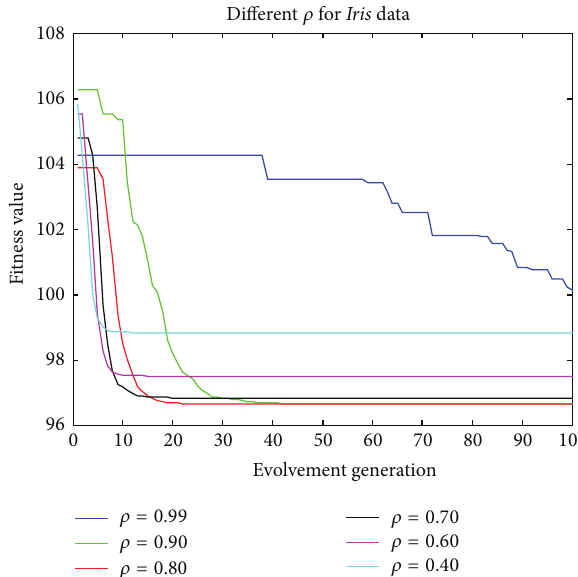
Figure 18: The convergence curve of the Iris with different 𝜌